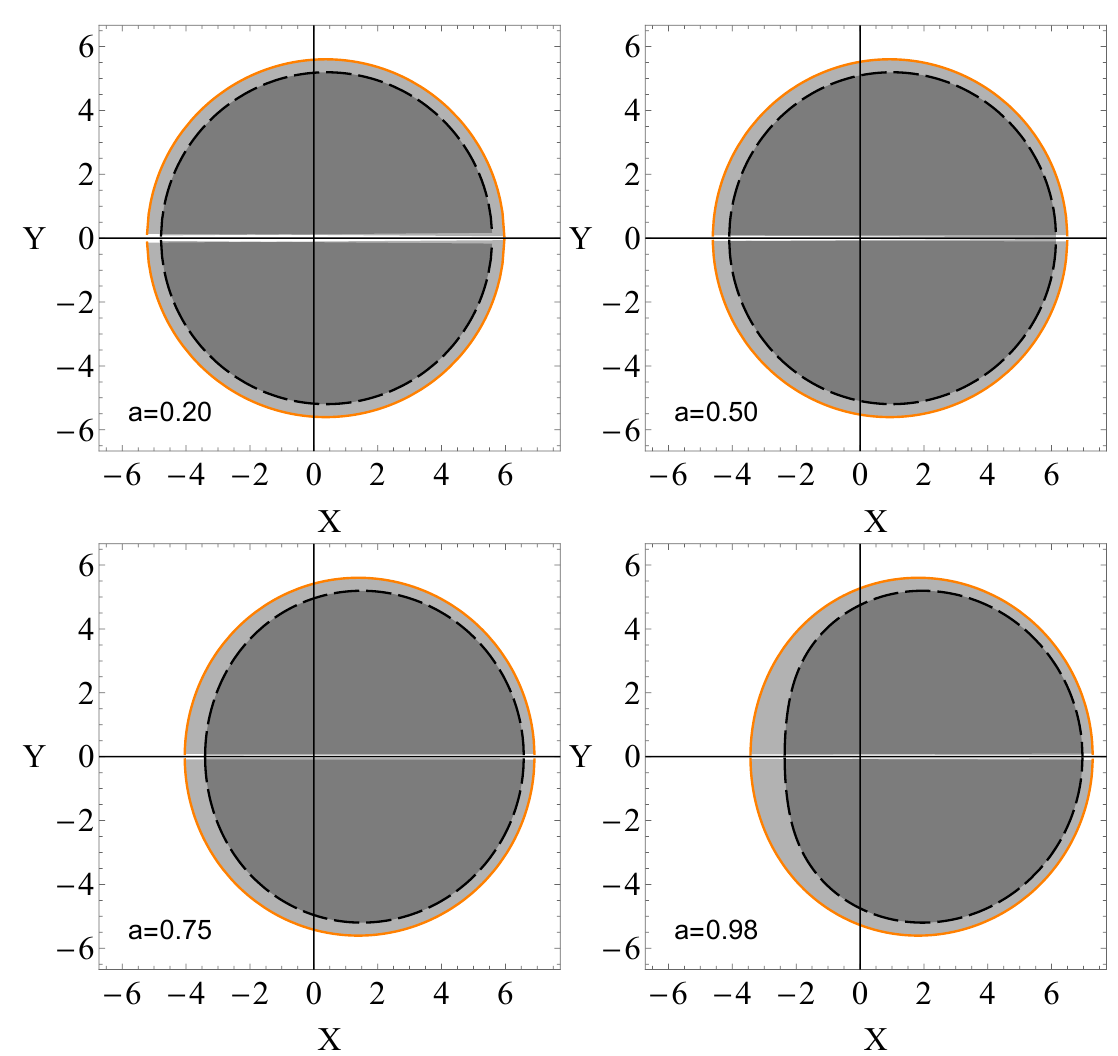
Figure 2. Shadows of spinning quantum deformed BHs using b = 1 (measured in units M ) and θ o = π /2. Note that the dashed curve represents the Kerr BH